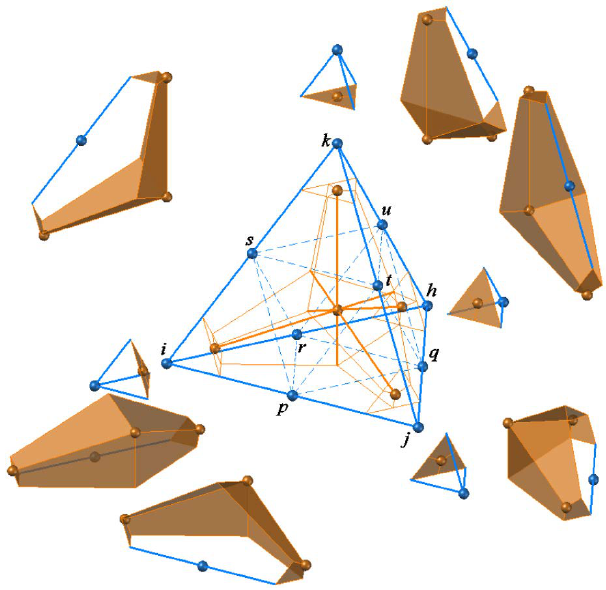
Figure 41: Construction of the dual polygons for a three-dimensional